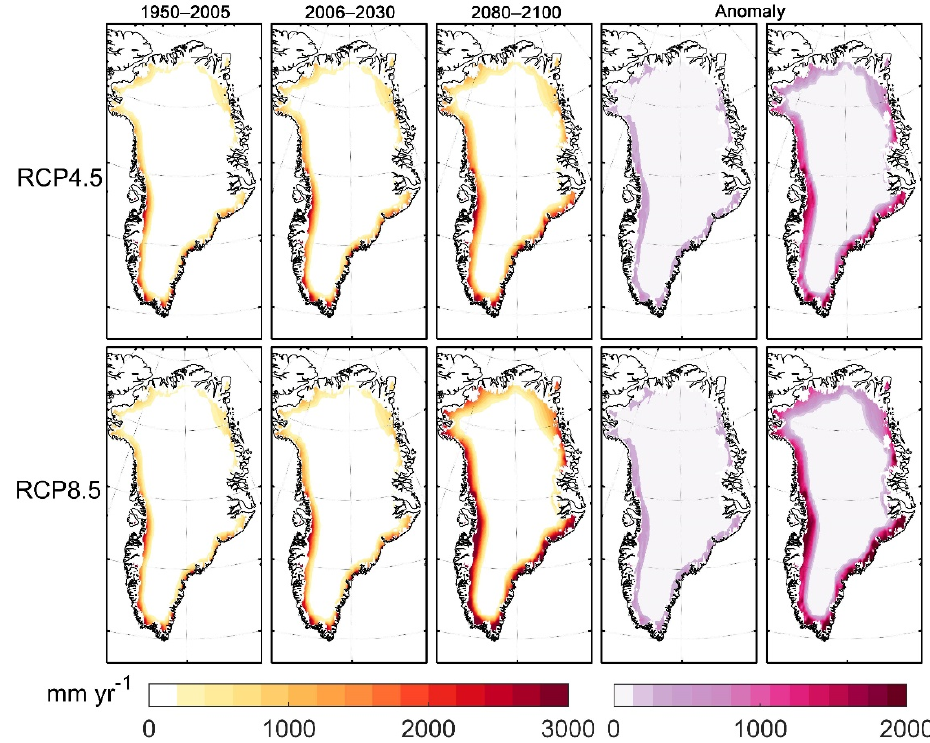
Figure 8. As for Figure 7, but the mean is estimated by two DD methods. Table 3. Mean and standard deviation of modeled runoff by DD methods and SEMIC, and compar- isons with different studies under historical and RCP scenarios (Gt yr − 1 ).